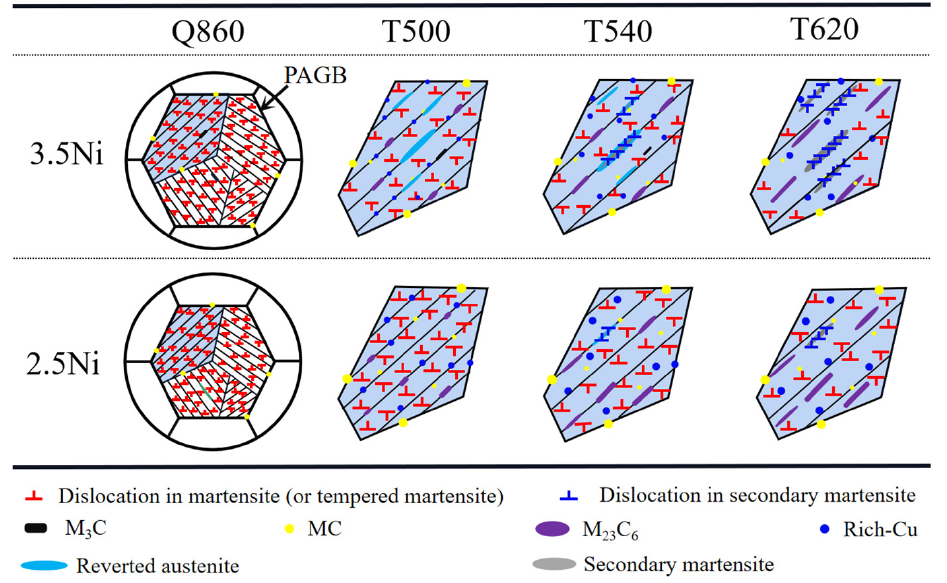
Figure 13. Schematic diagram of microstructure evolution of two steels after quenching and tempering at different temperatures.